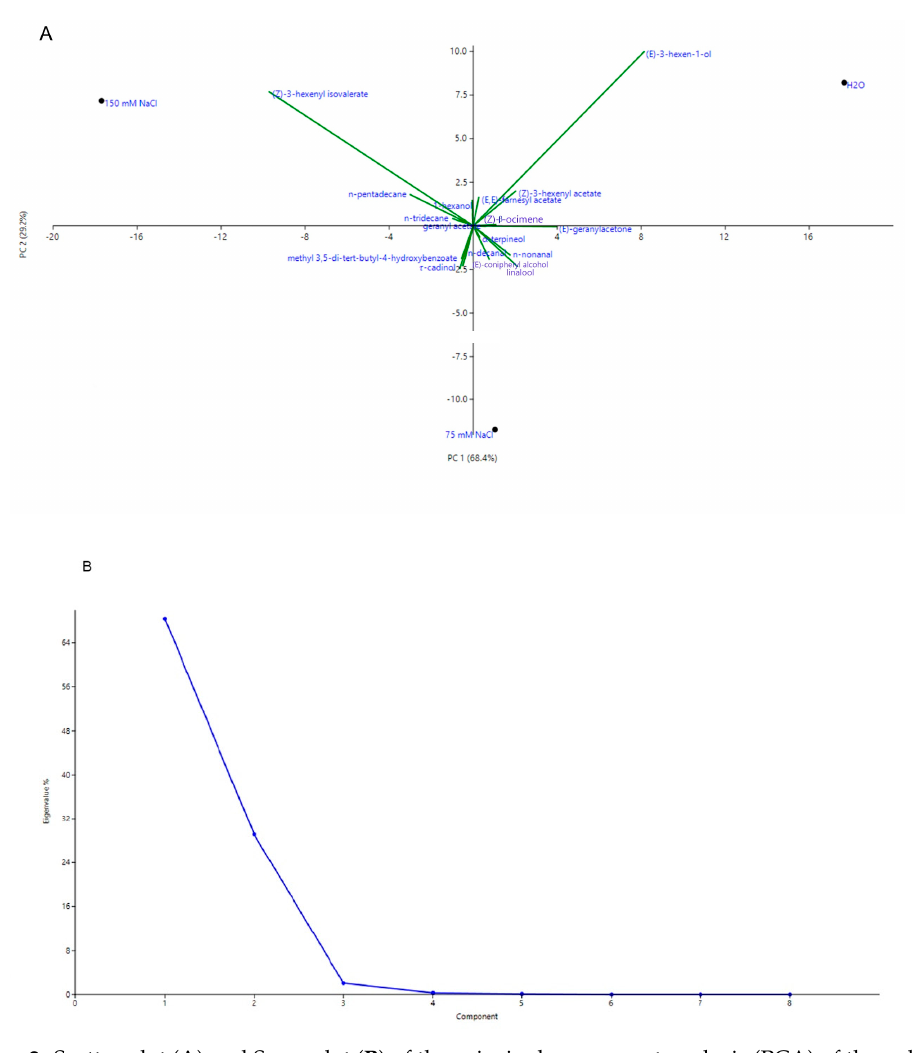
Figure 3. Dendrogram of the hierarchical cluster analysis (HCA) of the VOCs at different gradients of salinity.